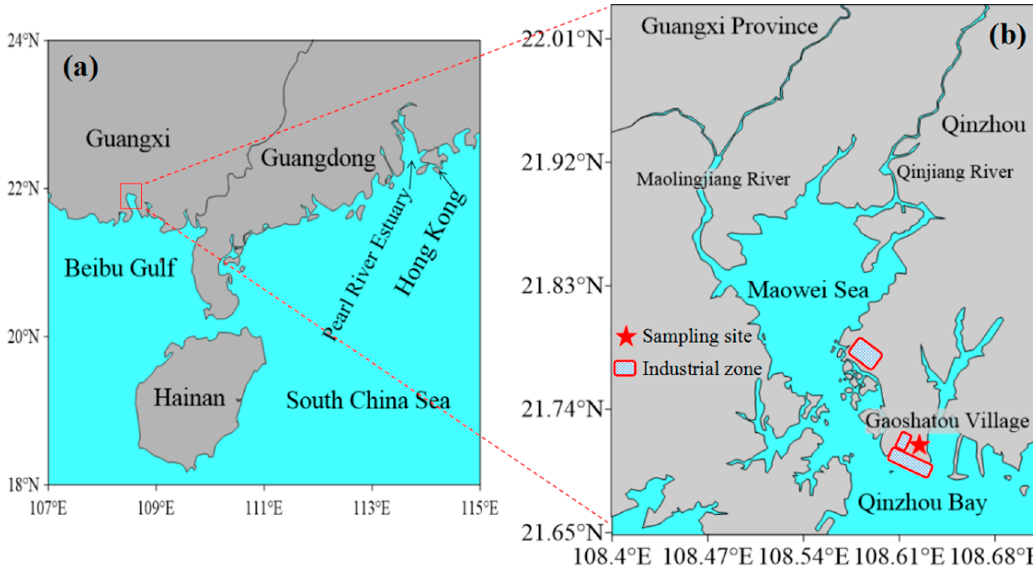
Figure 1. Map showing the study site location ( a ), sampling site and industrial zone ( b ) in Qinzhou